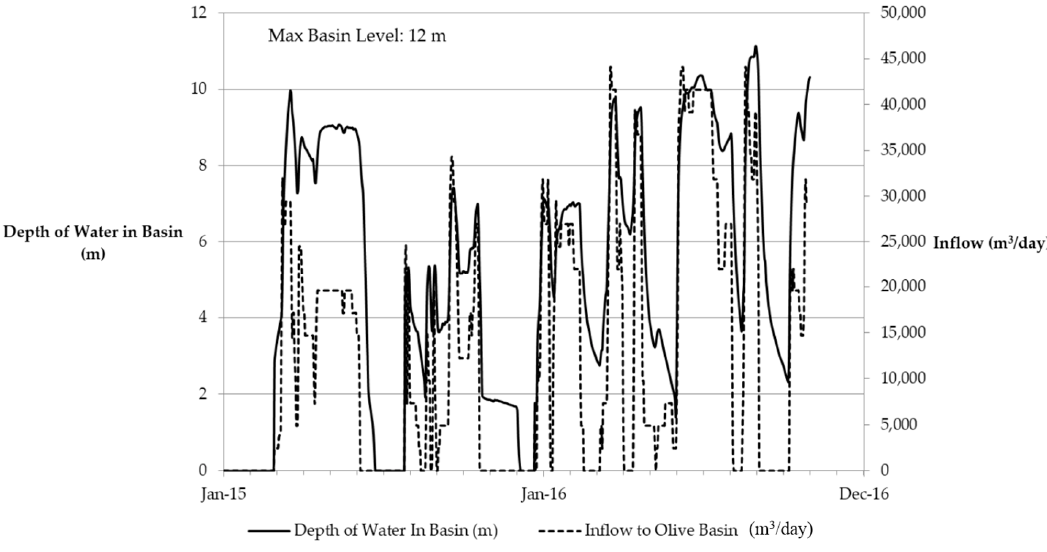
Figure 3. Depth of Water and Flow into Olive Basin.